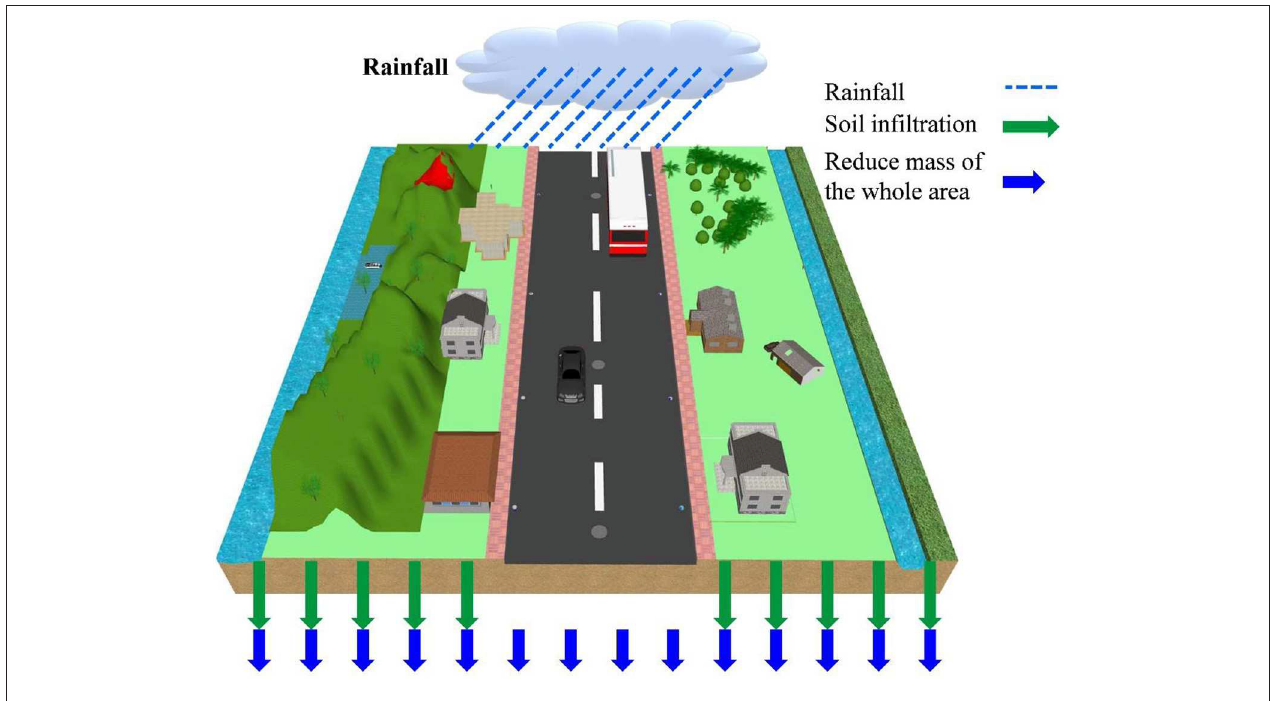
FIGURE 1 | Schematic diagram of the existing approach.